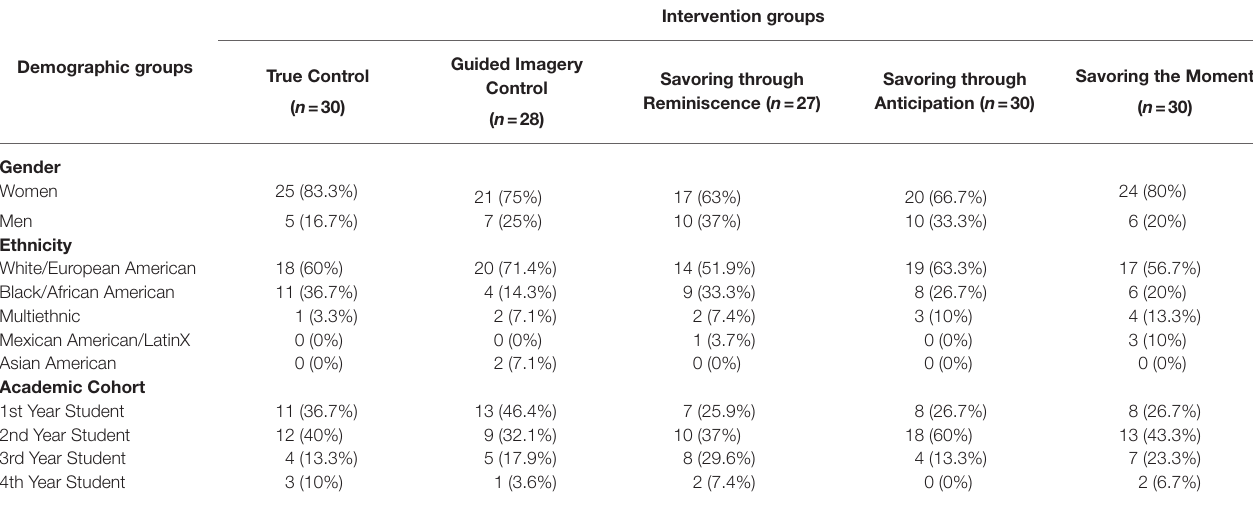
TABLE 2 | Sociodemographic and academic class standing breakdown of participants by intervention group.